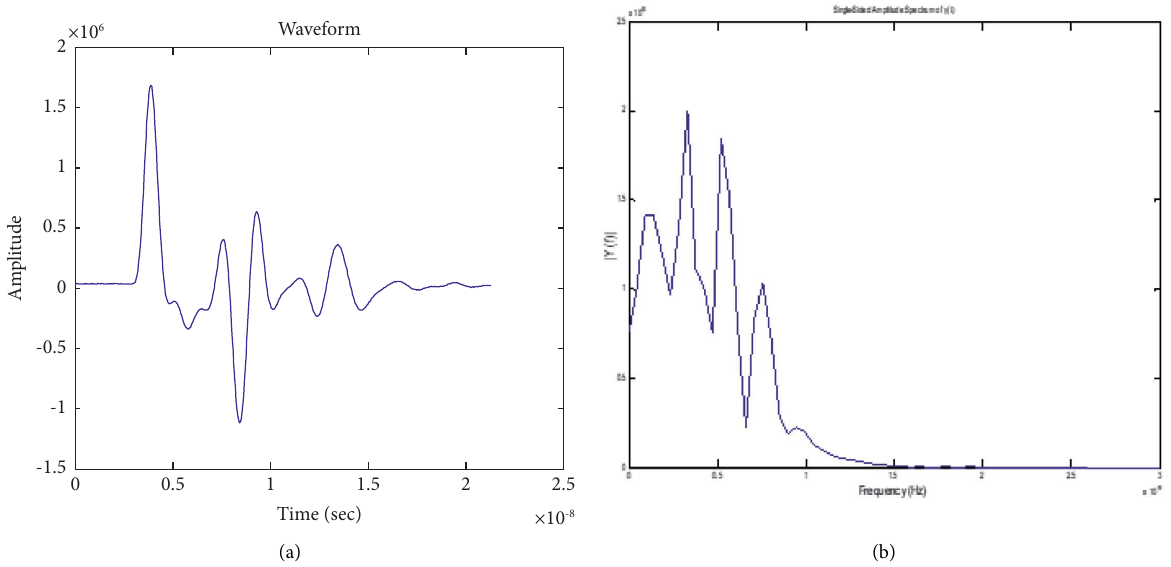
Figure 4: (a) GPR signal of wet ballast. (b) FFT spectrum of GPR signal of wet ballast.